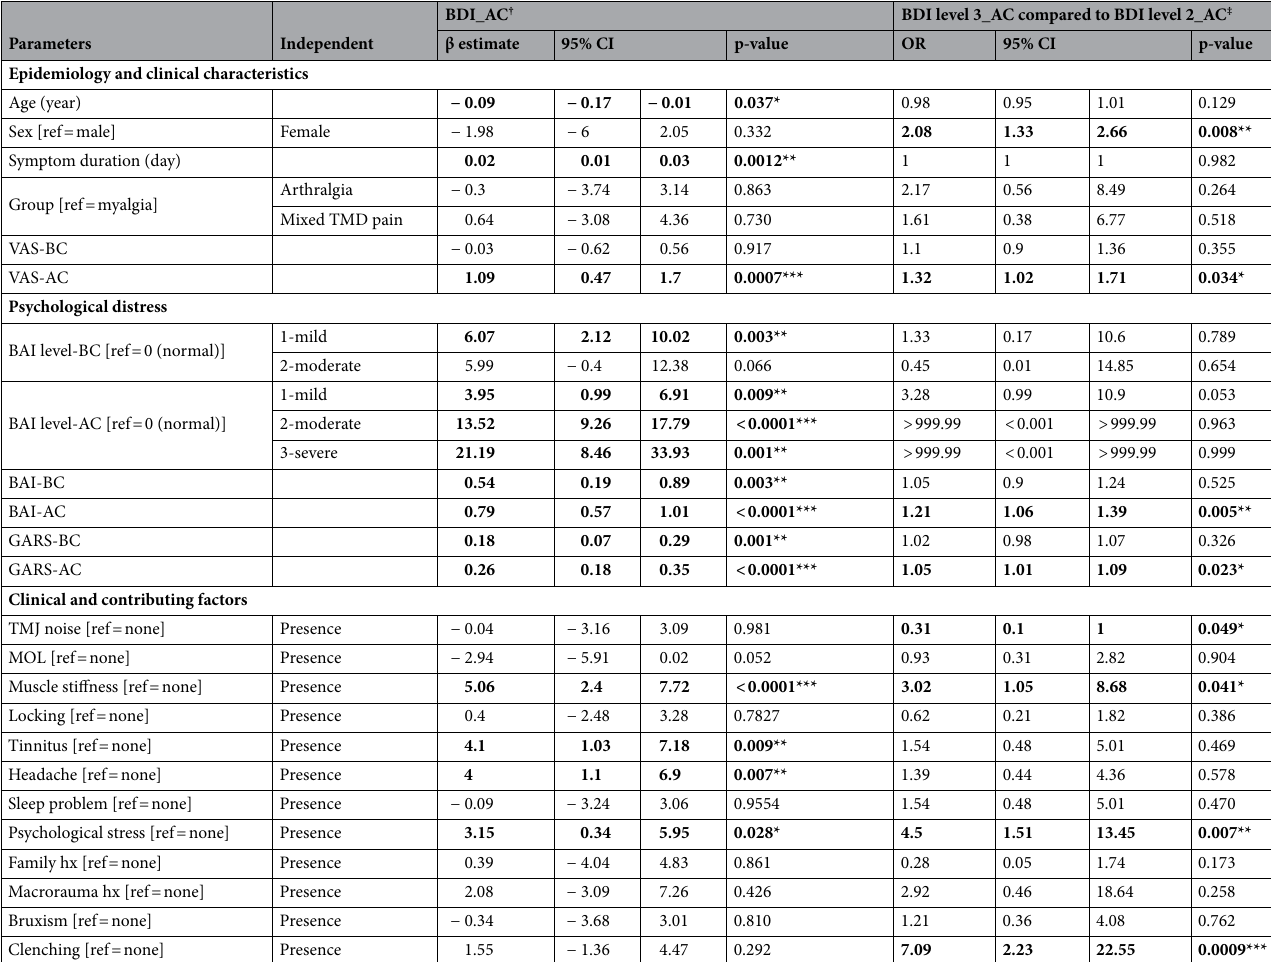
Table 3. Parameters related to the increase of depression after COVID-19. † Generalized linear model adjusted by BDI-BC, ‡ Multiple logistic regression analysis adjusted by BDI level-BC, significant p-value set at < 0.05, and significant results were bolded. *p-value < 0.05, **p-value < 0.01, ***p-value < 0.001. TMD: temporomandibular disorder; MOL: mouth-opening limitation; BDI: Beck Depression Inventory; BAI: Beck Anxiety Inventory; GARS: Global Assessment of Recent Stress; BC: before COVID-19, AC: after COVID-19, OR: odds ratio; CI: confidence interval; ref: reference; -BC: total score in BC; -AC: total score in AC; level-BC: level in